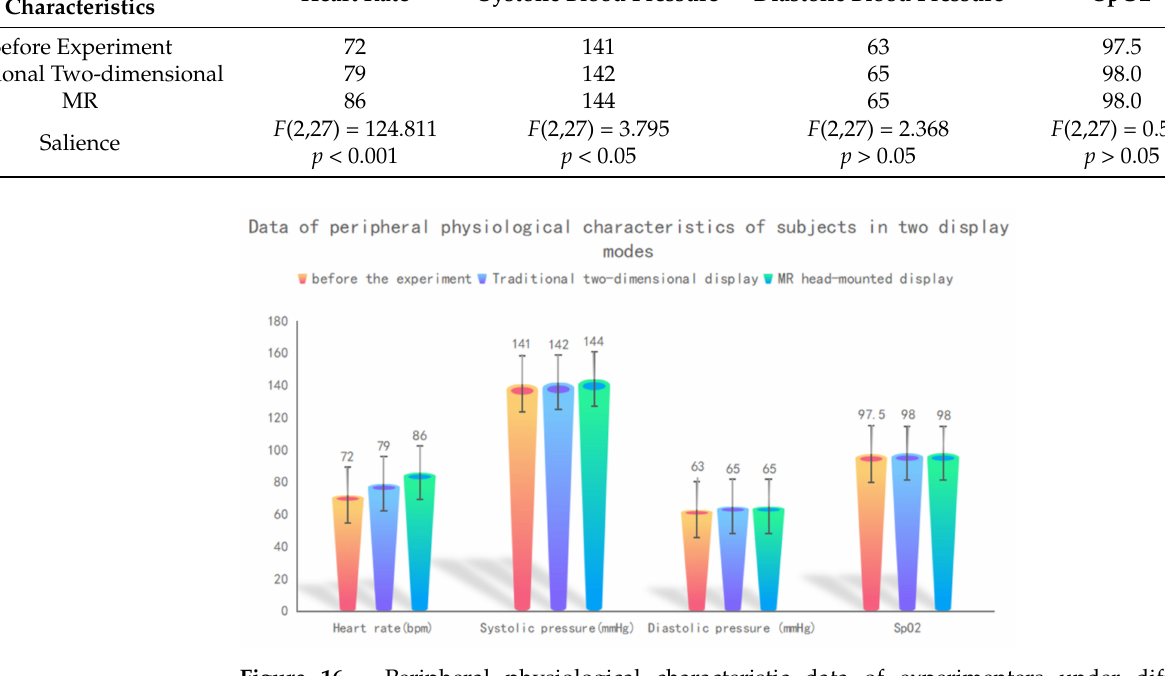
Figure 16. Peripheral physiological characteristic data of experimenters under different display